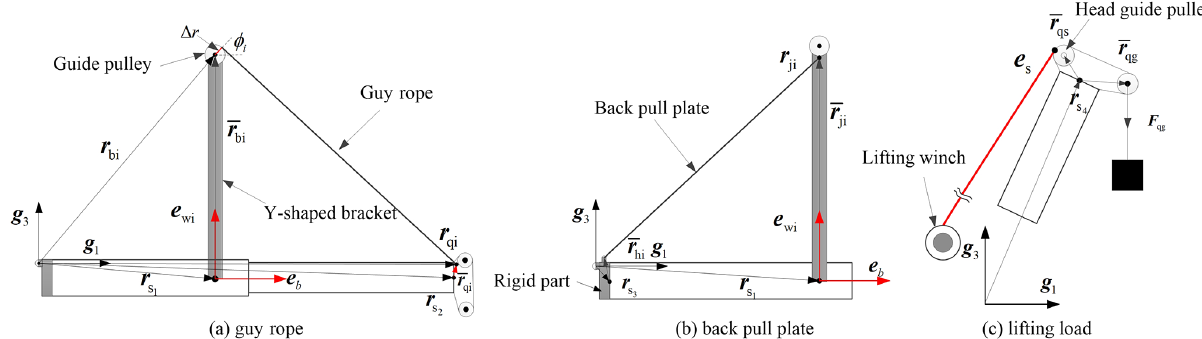
Figure 9. Guy rope, back plate, and lifting load